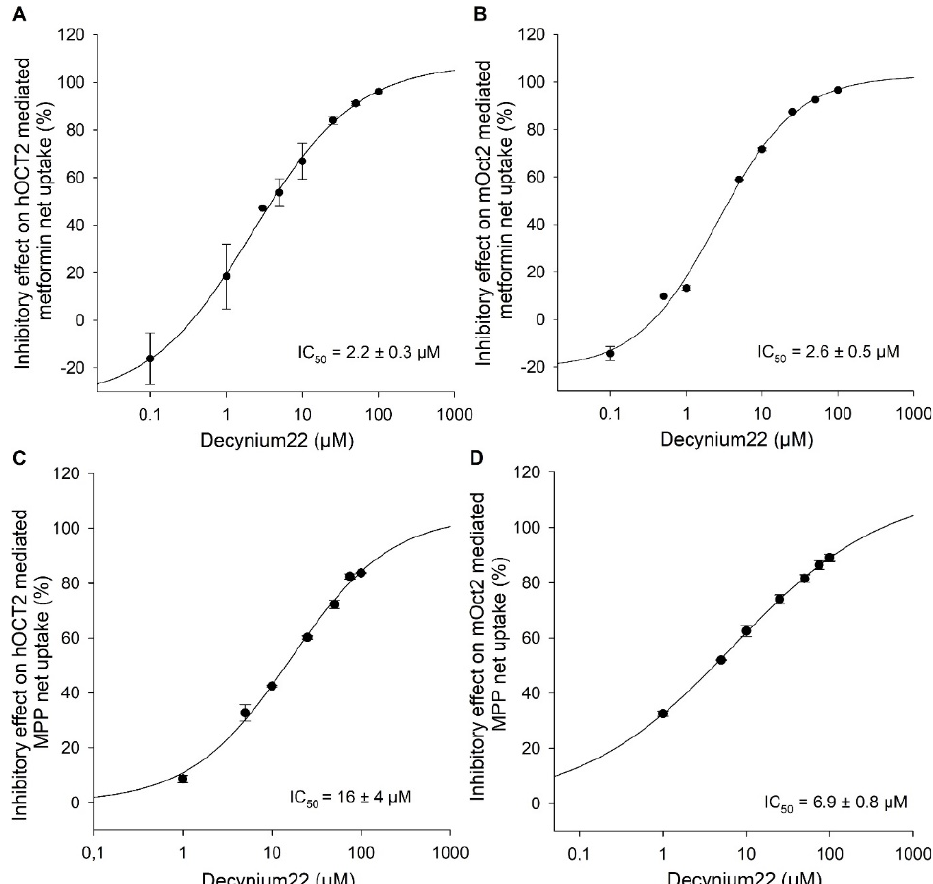
Figure 3. Concentration-dependent inhibitory effects of decynium22 on ( A ) hOCT2-, ( B ) mOct2- mediated 14 C-metformin transport and ( C ) hOCT2-, ( D ) mOct2-mediated 3 H-MPP transport in transfected HEK293 cells. Each data point represents the mean inhibitory effect (%) calculated from net-uptake of two independent experiments carried out in triplicate ± average deviation. IC 50 values were calculated by sigmoidal 4Hill equation using Sigma Plot version 13.0 software. The pesticides paraquat, glyphosate, atrazine, imidacloprid, amitraz, prochloraz and azoxystrobin showed very low inhibitory effects at 100 µ M on metformin accumulation in both OCT2 expressing cells (Table 2). Even so, some pesticides induced a stimulatory effect on the metformin uptake (Table 2), particularly amitraz on hOCT2. However, propamocarb and imazalil demonstrated the highest inhibition of hOCT2- or mOct2-mediated metformin uptake. Propamocarb at 100 µ M showed inhibitory effects of 55% in hOCT2 and of 48% in mOct2, respectively. At 10 µ M, the influence of propamocarb was negligible. In